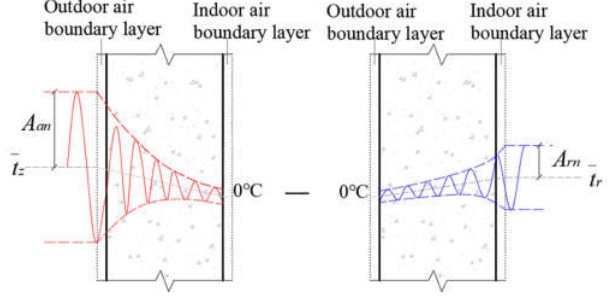
Figure 9. Attenuation of the thermal waves.